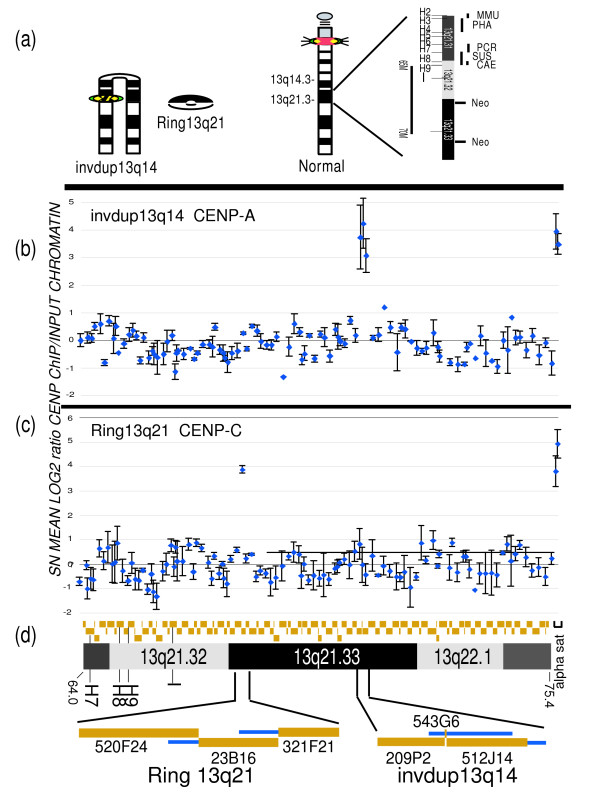
ChIP CHIP results on the two neocentromere cases. (a) Ideogrammatic representation of the neocentric chromosomes found in the two independent neocentromere cases. From left to right: the invdup13q14 chromosome with a neocentromere in band 13q21; the ring chromosome derived from band 13q21 to 13q22; a normal chromosome 13 for comparison. At the far right, the region 13q21.3 is expanded to show the relative position of BAC clones H2 to H9, along with the human neocentromeres and evolutionarily new centromeres of OWM and pig (see also Figure 2b). (b) ChIP on a CHIP analysis of the invdup13q14 chromosome using antibodies to CENP-A. (3) ChIP on a CHIP analysis of the ring13q21 chromosome using antibodies to CENP-C. For (b and c), the microarray was hybridized simultaneously with Cy-5 labeled CENP ChIP DNA (red) and Cy3 labeled input chromatin DNA (green). The scale normalized mean Log2 Cy-5:Cy-3 ratios and standard error for each BAC are shown plotted on the y-axis for three independent ChIP experiments. Alpha satellite DNA was included in the microarray as a positive control (far right). (3) Position of 107 contiguous BACs spanning 13q21 to 13q22 is shown across the x-axis. Positions of probes H7, H8, H9 and I (Table 1) are shown. Bottom: blow up of BACs that are positive for CENP proteins. Thin lines represent regions of BAC overlap. Scale in Mbp according to UCSC genome coordinates hg17 [Bioinformatics, #9821].